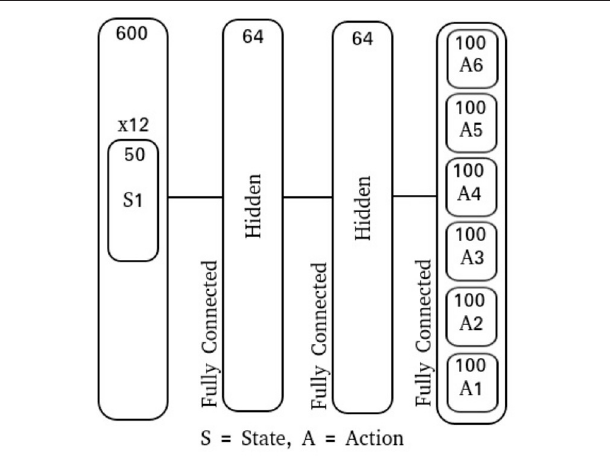
FIGURE 5 | Locomotion network